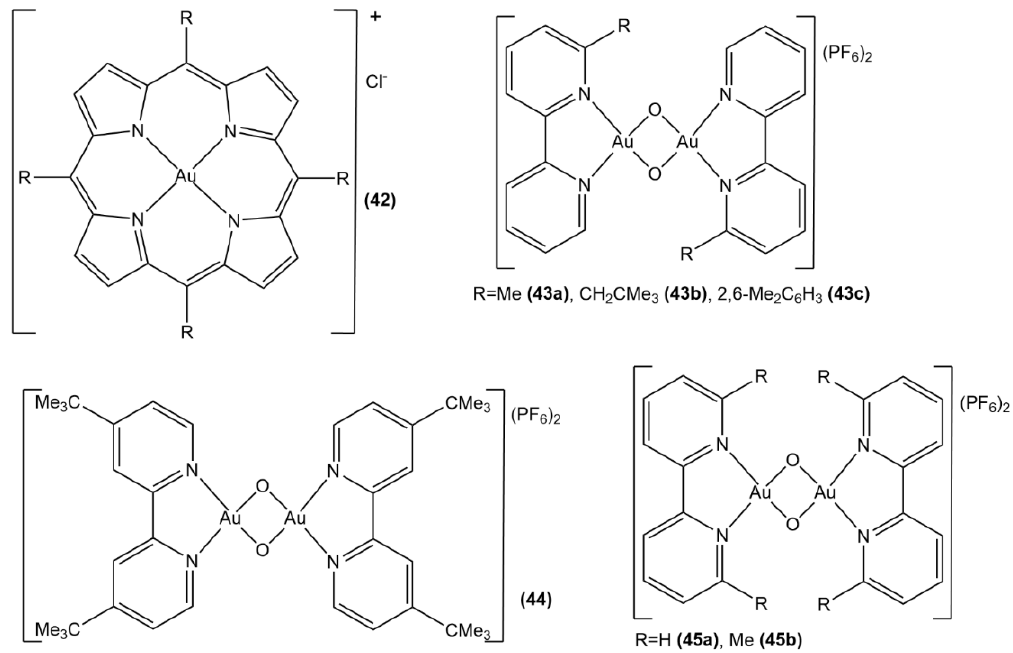
Figure 19. Au(III) complexes with porphyrinate ( 42 ) and oxo-bridged binuclear gold(III) com- pounds ( 43a – 43c , 44 , 45a , 45b